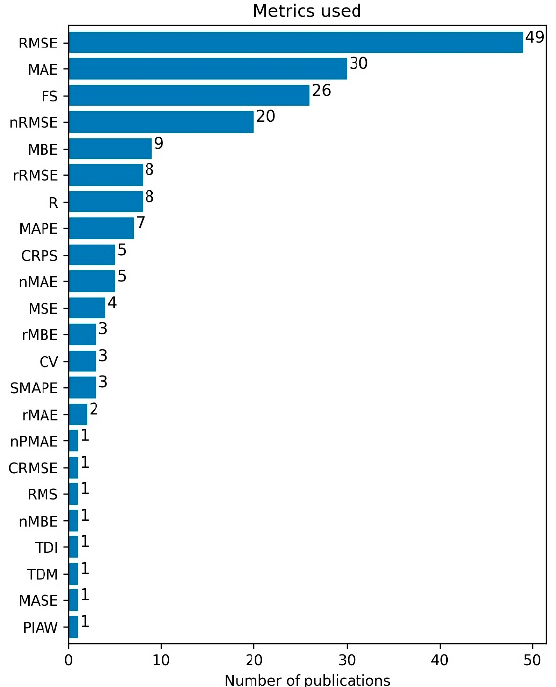
Figure 4. Histogram describing the frequency of use of the metrics from works tackling spatio-temporal solar forecasting. Publications that consider more than one metric will contribute at the same time to different bins of the histogram.